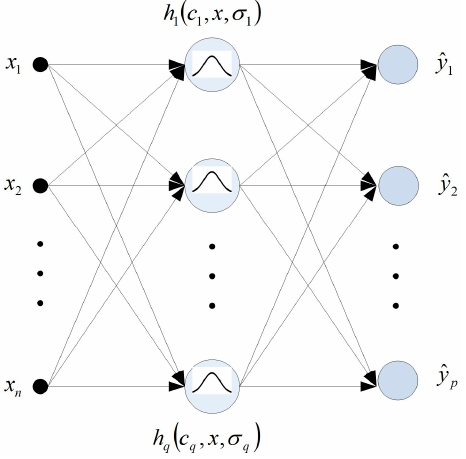
Figure 2. Radial basis function network (RBFN) structure.